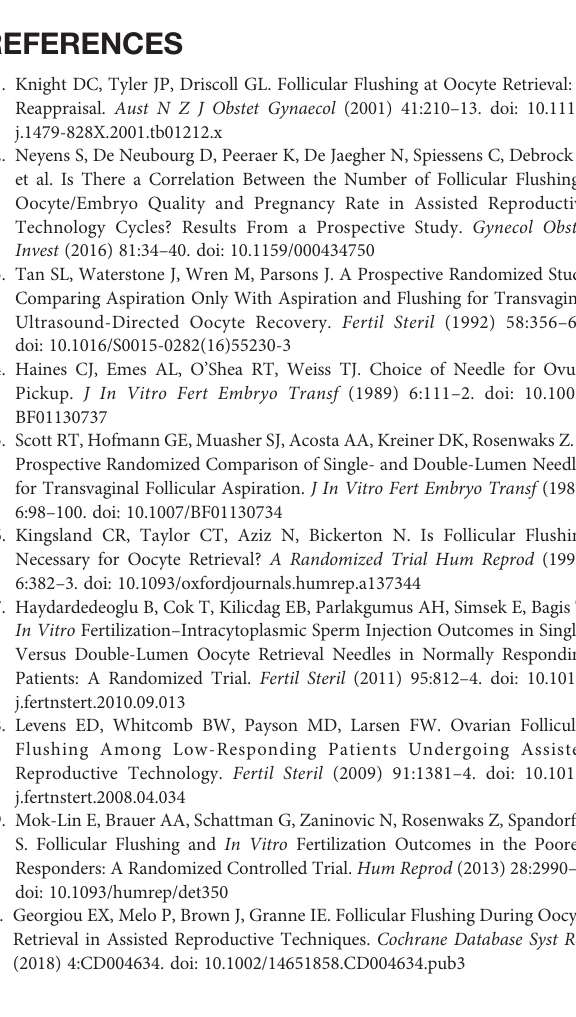
Supplementary Table 1 | Subgroup analysis of poor and normal respond cycles in ORNS and ORS. *Chi squre compare the ratio of ORNS and ORS in poor responder and normal responder groups.